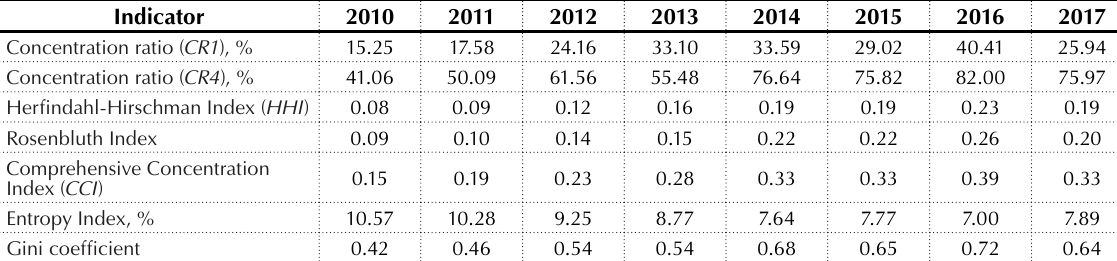
Table 6. Indicators of market concentration,